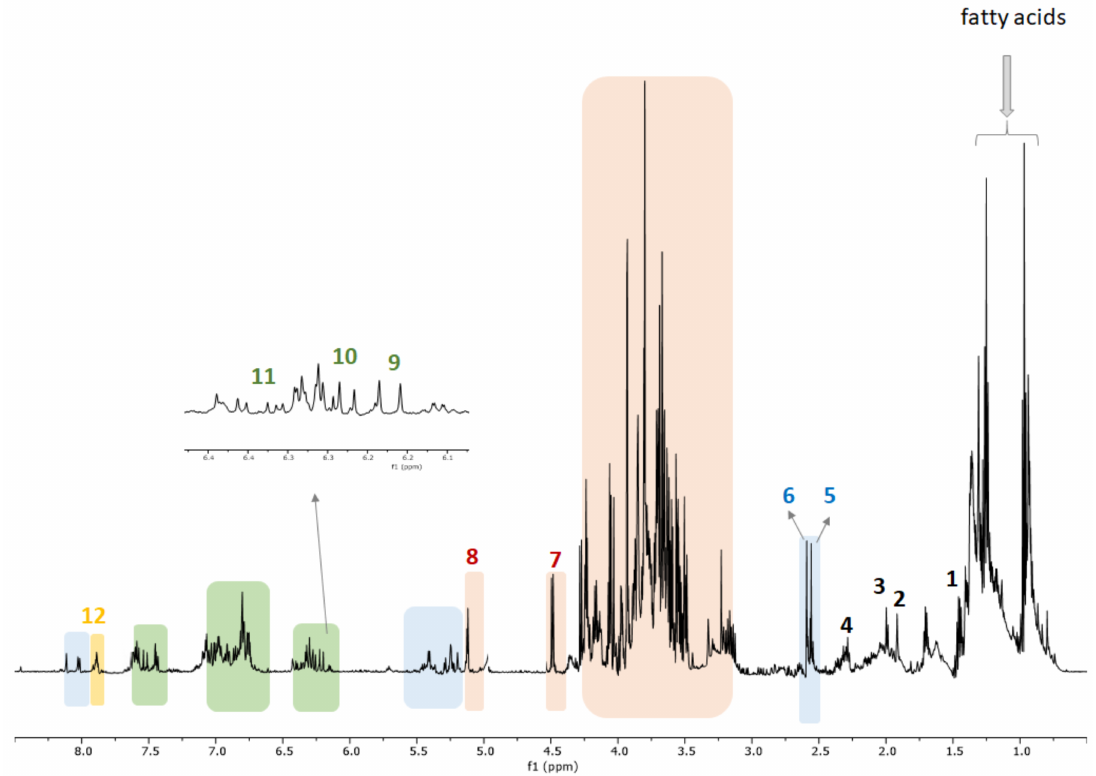
Figure 3. 1 H NMR spectrum with annotations of identified metabolites detected in H. italicum : Alanine ( 1 ); GABA ( 2 ); lysine ( 3 ); valine ( 4 ); 12-hydroxytremetone ( 5 ); gnaphaliol ( 6 ); β -glucose ( 7 ); α -glucose ( 8 ); 3,4-dicaffeoylquinic acid ( 9 ); chlorogenic acid ( 10 ); 3,5-dicaffeoylquinic acid ( 11 ); kaempferol 3- O -glucopyranoside ( 12